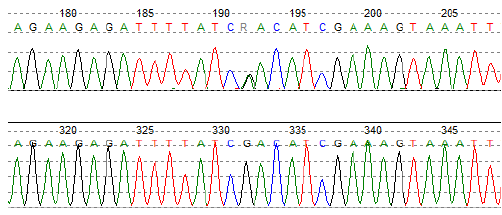
Figure 7. Sanger sequencing chromatogram shows heterozygous c.106G>A variant in the exon 2 of the LPL